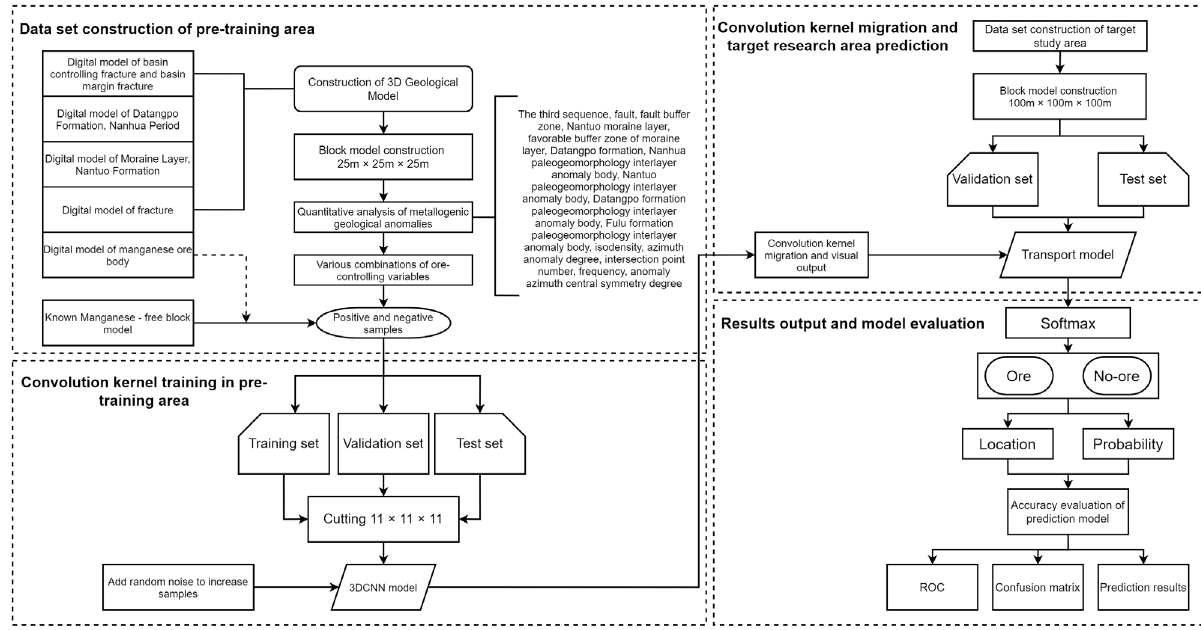
Figure 4. The flow chart of transfer learning.